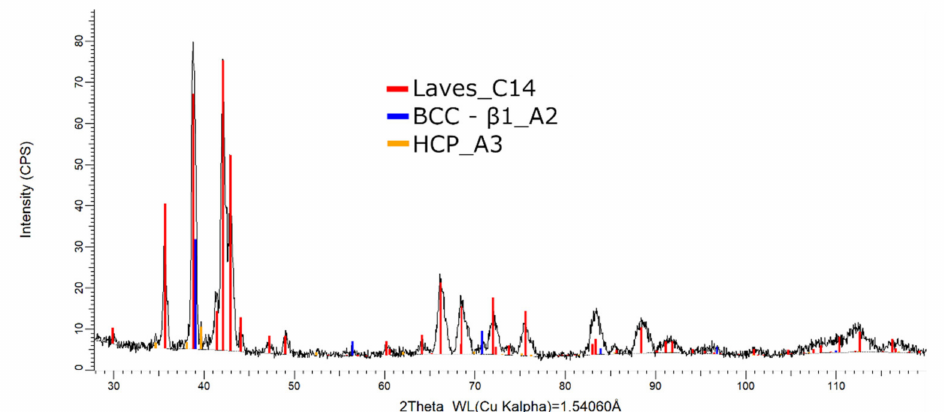
Figure 19. EDS mapping of the FeMnNb 0.5 TiZr 0.5 alloy.